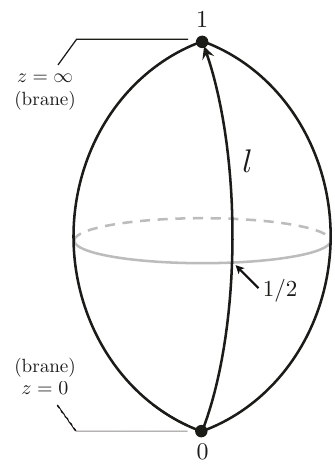
Figure 2 . \Football"-shaped sphere with two branes at z = 0 ;